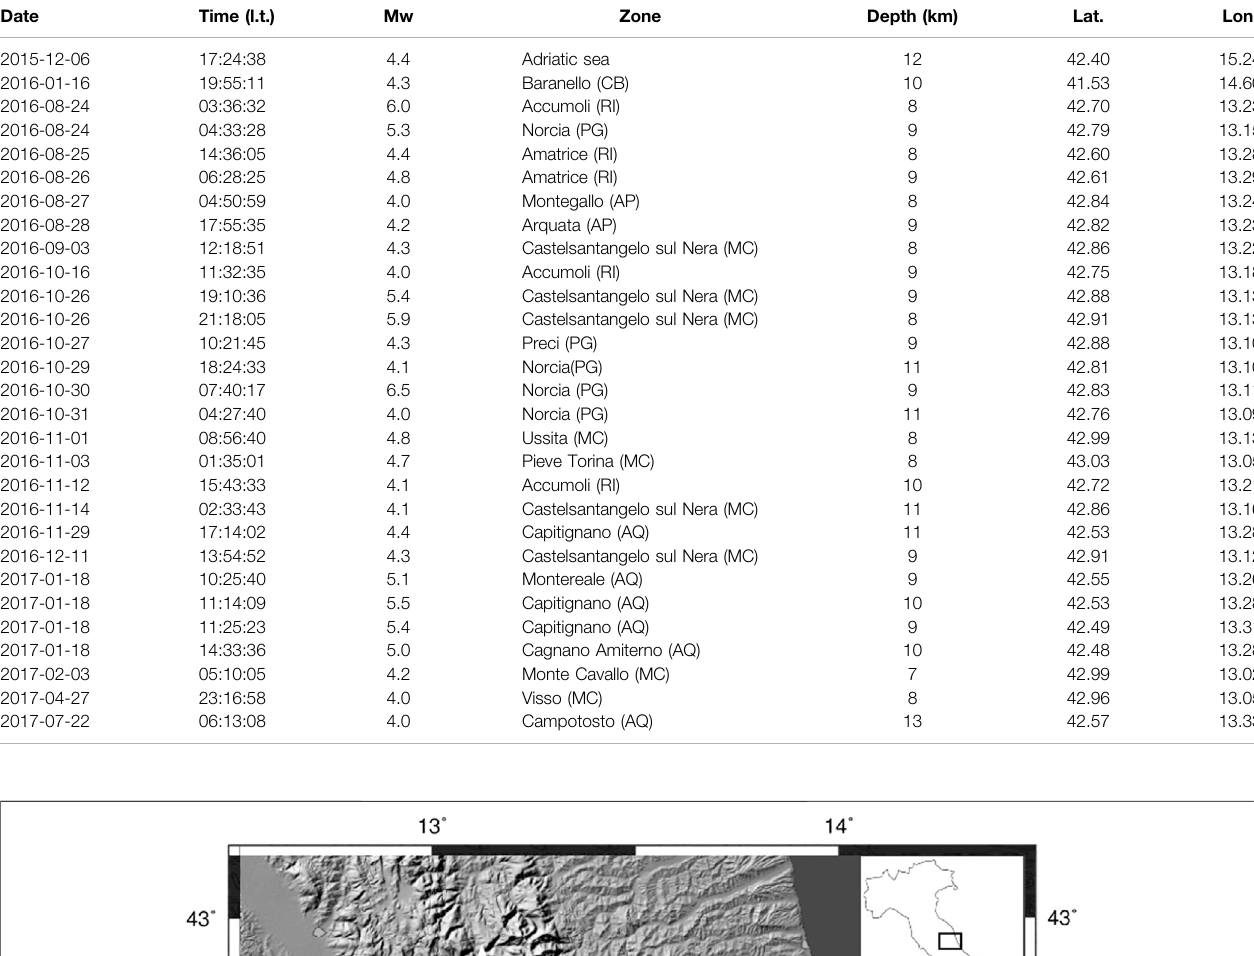
TABLE 1 | List of the 29 earthquakes localized within a distance of 150 km from Chieti with M ≥ 4 shown in Figures 5, 6, 9 . Seismic events with 4 ≤ M < 5 are omitted when occurred the same day of a seismic event with M ≥ 5, and only the major with 4 ≤ M < 5 is reported when more than one event occurred the same day. Of fi cial data are taken from the INGV website at http://terremoti.ingv.it. Time (l.t.) Mw Zone Depth (km) Lat. Lon.